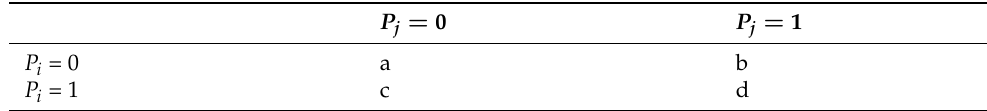
Table 1. This is the contingency table of the results of classifiers P i and P j . P j = 0 P j = 1 P i = 0 a b